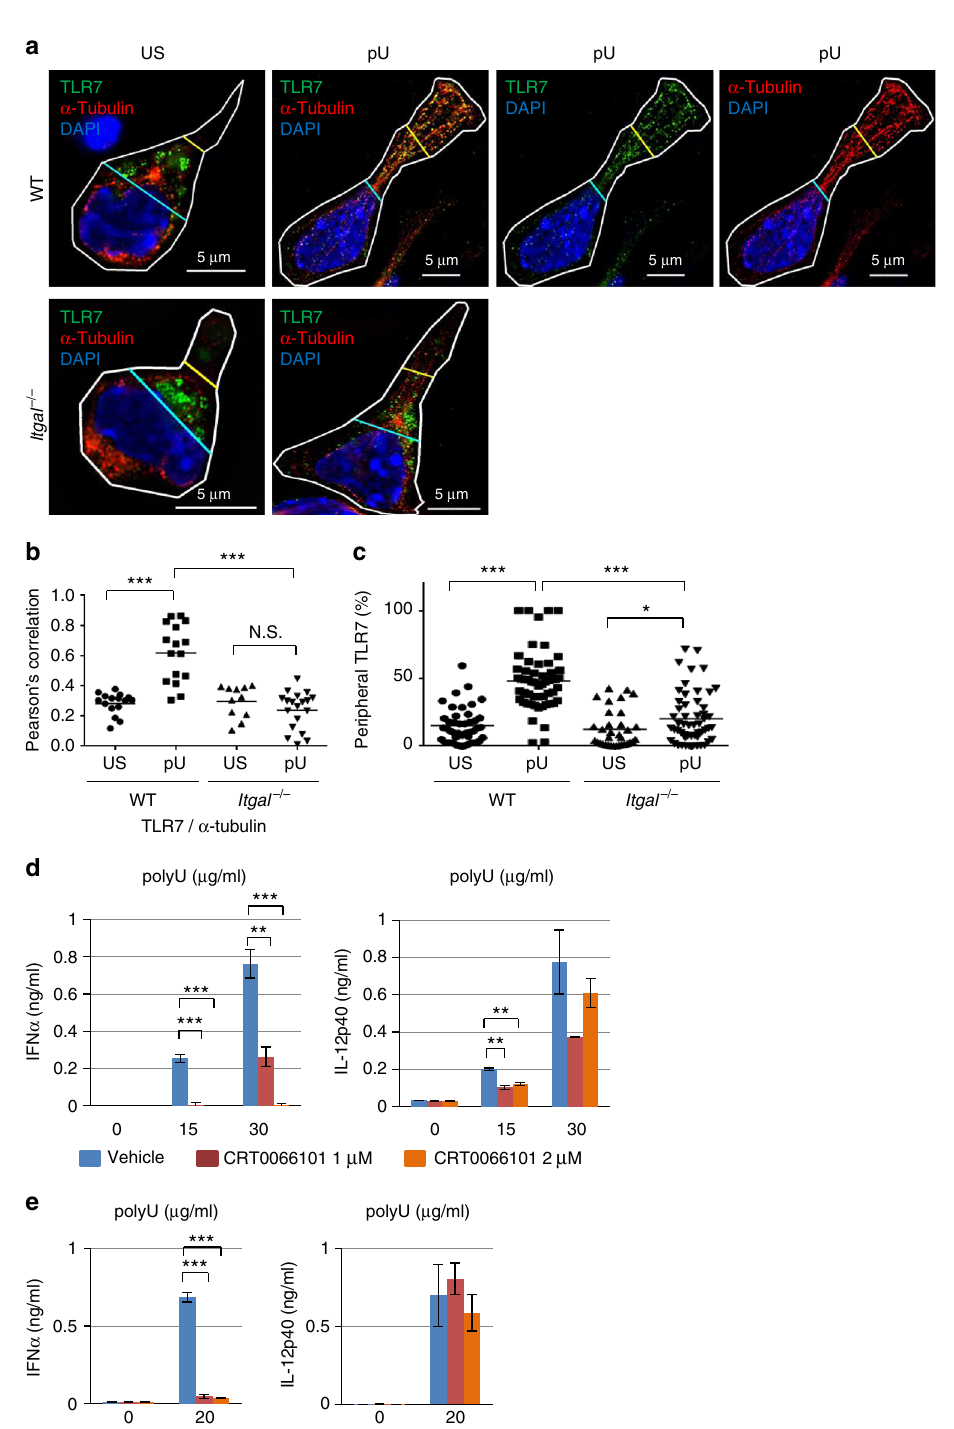
Fig. 2 TLR7 traf fi cking to cell periphery and IFN- α induction depend on CD11a/CD18 activation. a WT and Itgal − / − BM-pDCs were either left unstimulated (US) or activated (pU) with 25 μ g/mL polyU for 4 h. Abs against TLR7 (green), and α -tubulin (red) were used together with DAPI staining of cell nuclei (blue) prior to analysis by structured illumination microscopy (SIM). Plasma membranes are indicated by white line. Blue lines are placed at the boundary between cytoplasm and nucleus. Yellow lines are at the middle of blue lines and the tip of the polarized cytoplasm. These lines were used for quanti fi cation of TLR7 traf fi cking. b Quanti fi cation of TLR7 co-localization with α -tubulin ( n > 10). c To quantify TLR7 traf fi cking to the cell periphery, the cytoplasm was fi rst divided by perinuclear and peripheral regions as indicated by blue and yellow lines ( a ). Shown is a percentage of peripheral TLR7 ( n > 33). d , e BM- pDCs were pretreated with protein kinase D (PKD) inhibitor CRT0066101 ( d ) or integrin-linked kinase (ILK) inhibitor Cpd22 ( e ) for 1 h at the indicated concentration, and then stimulated with polyU at 15, 30, or 20 μ g/mL for 24 h. Production of IFN- α and IL-12 p40 was measured by ELISA. Data shown are mean ± s.d. from triplicate wells. The experiments were repeated three times with similar results. 5 μ m ( a ). *** P < 0.001, ** P < 0.01, * P < 0.05 (unpaired two-tailed t